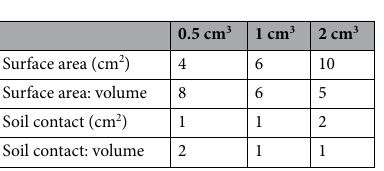
Table 1. Geometry of the wood blocks in three different sizes used in the present